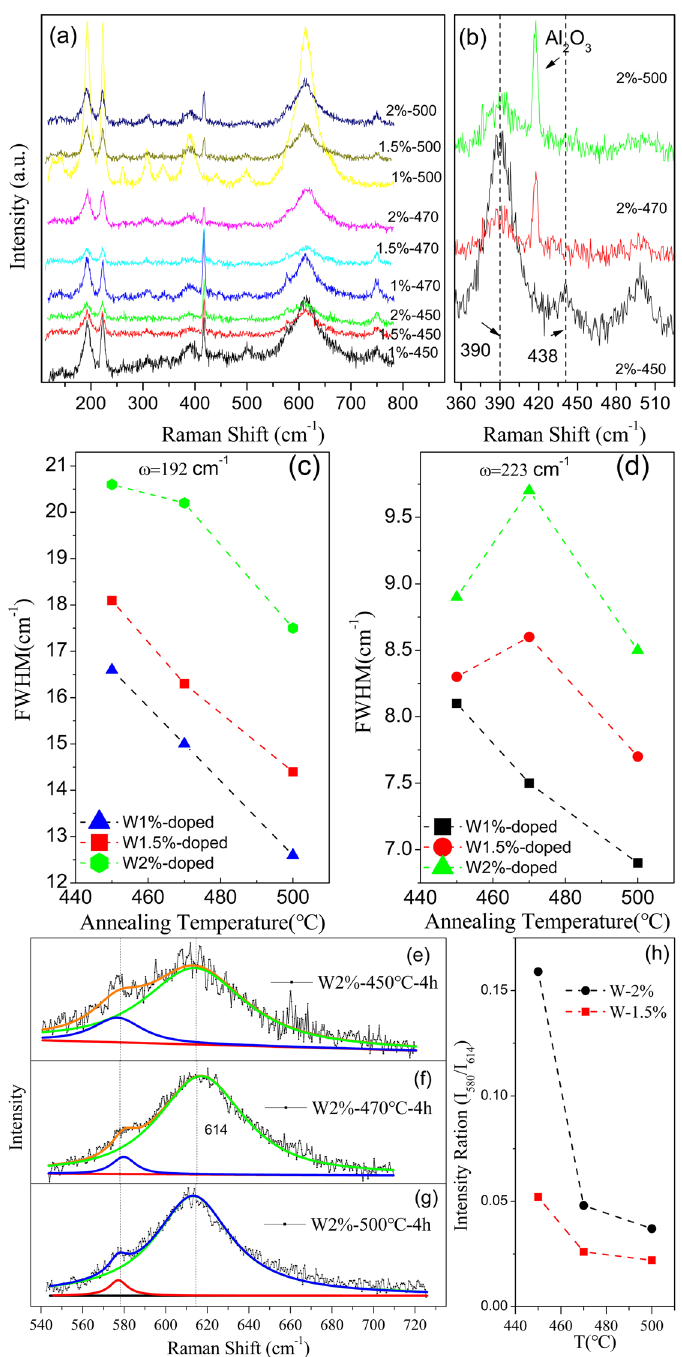
Figure 3. ( a ) Raman spectra of the films annealed at 450, 470 and 500 °C; ( b ) The magnified Raman spectra in the range of 350~520 cm − 1 for 2% W-doped samples annealed at different temperatures; ( c , d ) the annealing temperature dependent FWHMs of the peaks at 192 and 223 cm − 1 ; ( e ~ g ) the V-O related vibration mode positions of films with nominal 2 at.% W annealed at 450, 470 and 500 °C; ( h ) the annealing temperature dependent integrated intensity ratio of peaks at 580 and 614 cm − 1